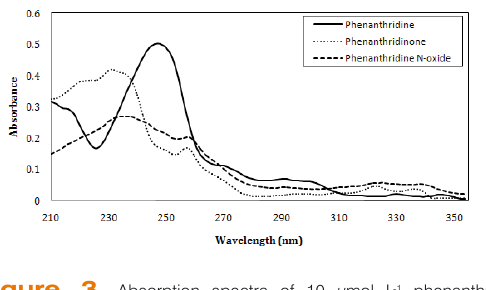
Figure 3. Absorption spectra of 10 µmol L -1 phenanthridine, phenanthridinone and phenanthridine N-oxide